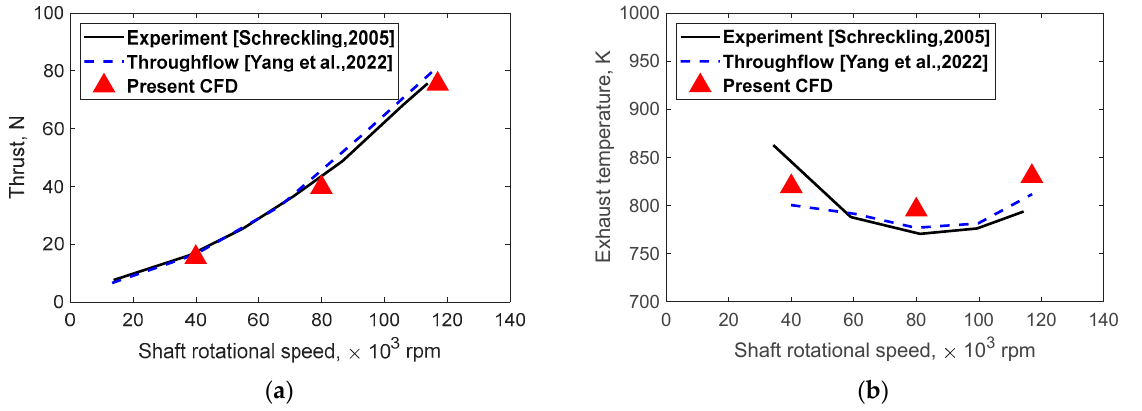
Figure 5. Full engine validation results against the experiment of Schreckling [42] and throughflow simulations of Yang et al. [44] for: ( a ) engine thrust; ( b ) exhaust temperature.